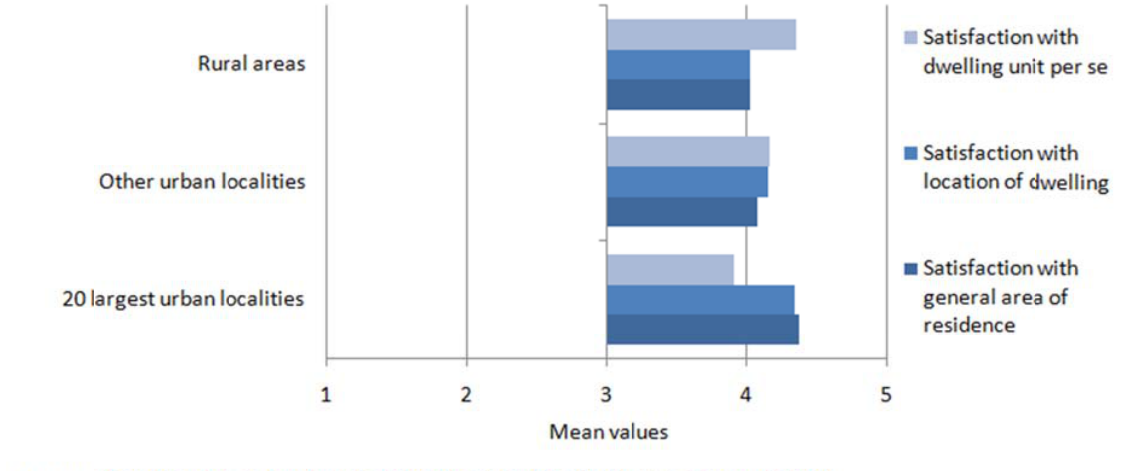
Figure 3 area (mea Men